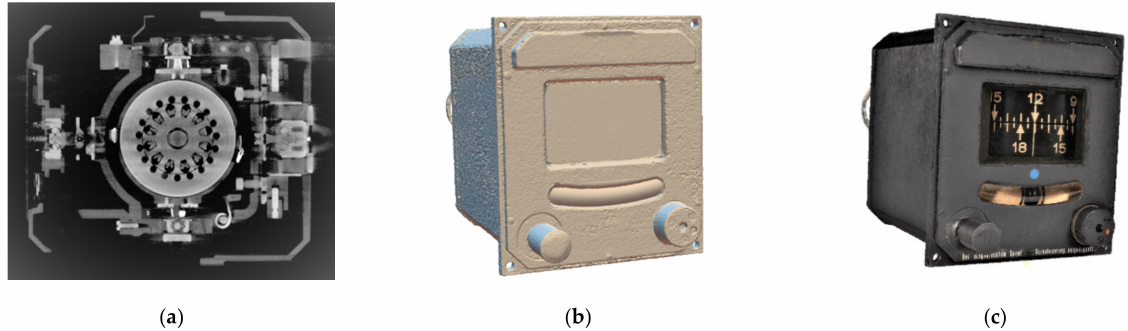
Figure 26. A 3D digital twin of the LKu4: ( a ) CT scan; ( b ) CV/photogrammetry point cloud mesh with normal and sprayed images; and ( c ) the CT/CV integrated